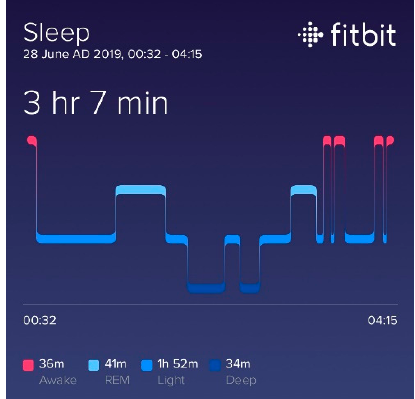
Figure A6. Krabi,